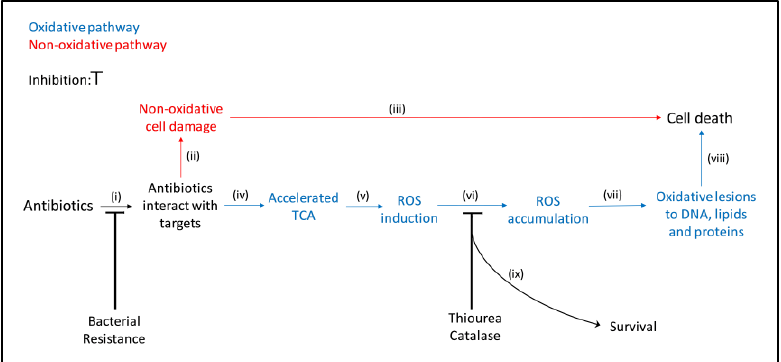
Figure 1. Schematic mechanisms of the main steps involved in the bactericidal activity of antibiotics. When antibiotics interact with their targets, (i) primary damage may occur. If this primary damage is severe and independent of oxidative stress, (ii) bacteria are not able to repair the damage (iii) and die (red). If the primary damage is insufficient to the kill the bacteria directly, the tricarboxylic acid cycle (TCA) (iv) may be accelerated, leading to the formation of ROS (v). Accumulation of ROS (vi) may cause secondary damage by introducing oxidative lesions in DNA, lipids and proteins (vii), resulting in killing of the bacteria (viii). Modified from Kohanski et al., 2007, Zhao et al., 2015, Van Acker and Coenye, 2017 [11–13]. In this study, the involvement of the oxidative pathway in the bactericidal activity of daptomycin was evaluated by the increased survival (ix) and the decreased ROS formation when ROS was removed with catalase or scavenged with thiourea (vi) and by preventing interactions with the targets in a resistant isolate (i).